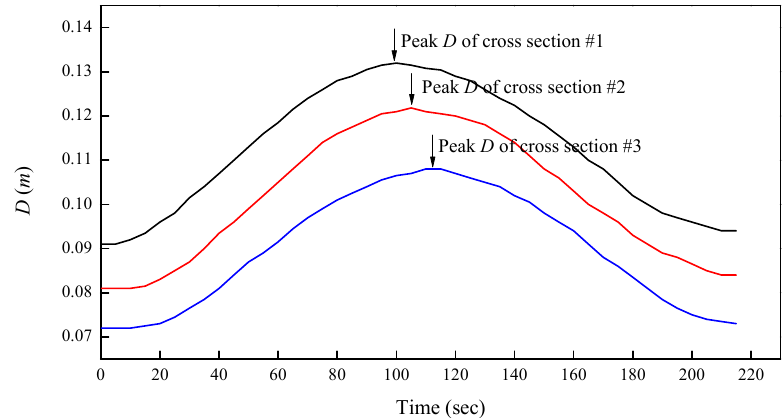
Figure 3. The flow depth hydrographs of the No. 1-1 flood event.